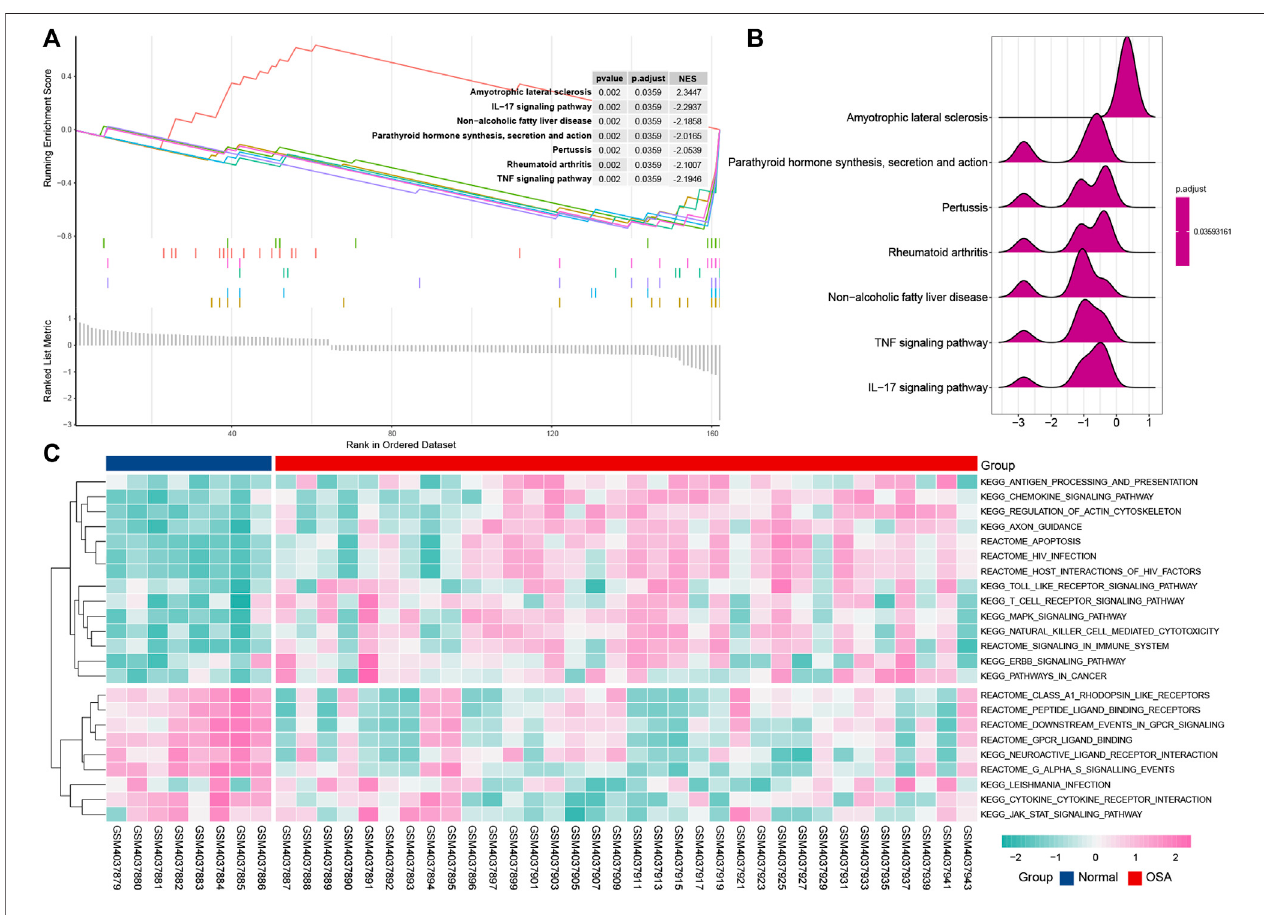
FIGURE 6 | Pathway enrichment analysis of the immune-related DEGs. Gene set enrichment analysis (GSEA) displays the top 7 enriched pathways in OSA using enrichment plots (A) and ridge plots (B) . (C) Gene set variation analysis (GSVA) for signi fi cantly enriched pathways in OSA.